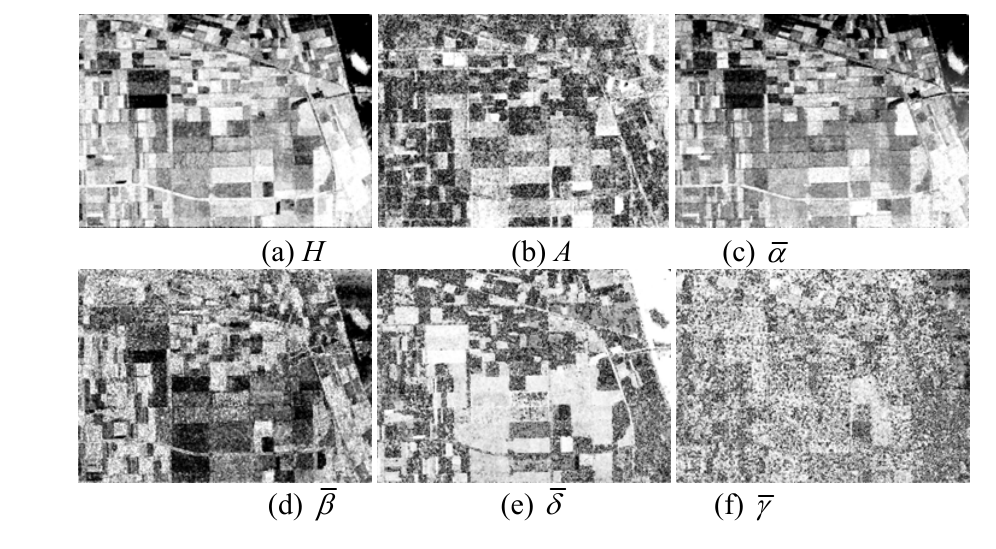
Figure 17. Parameters of H/A/Alpha